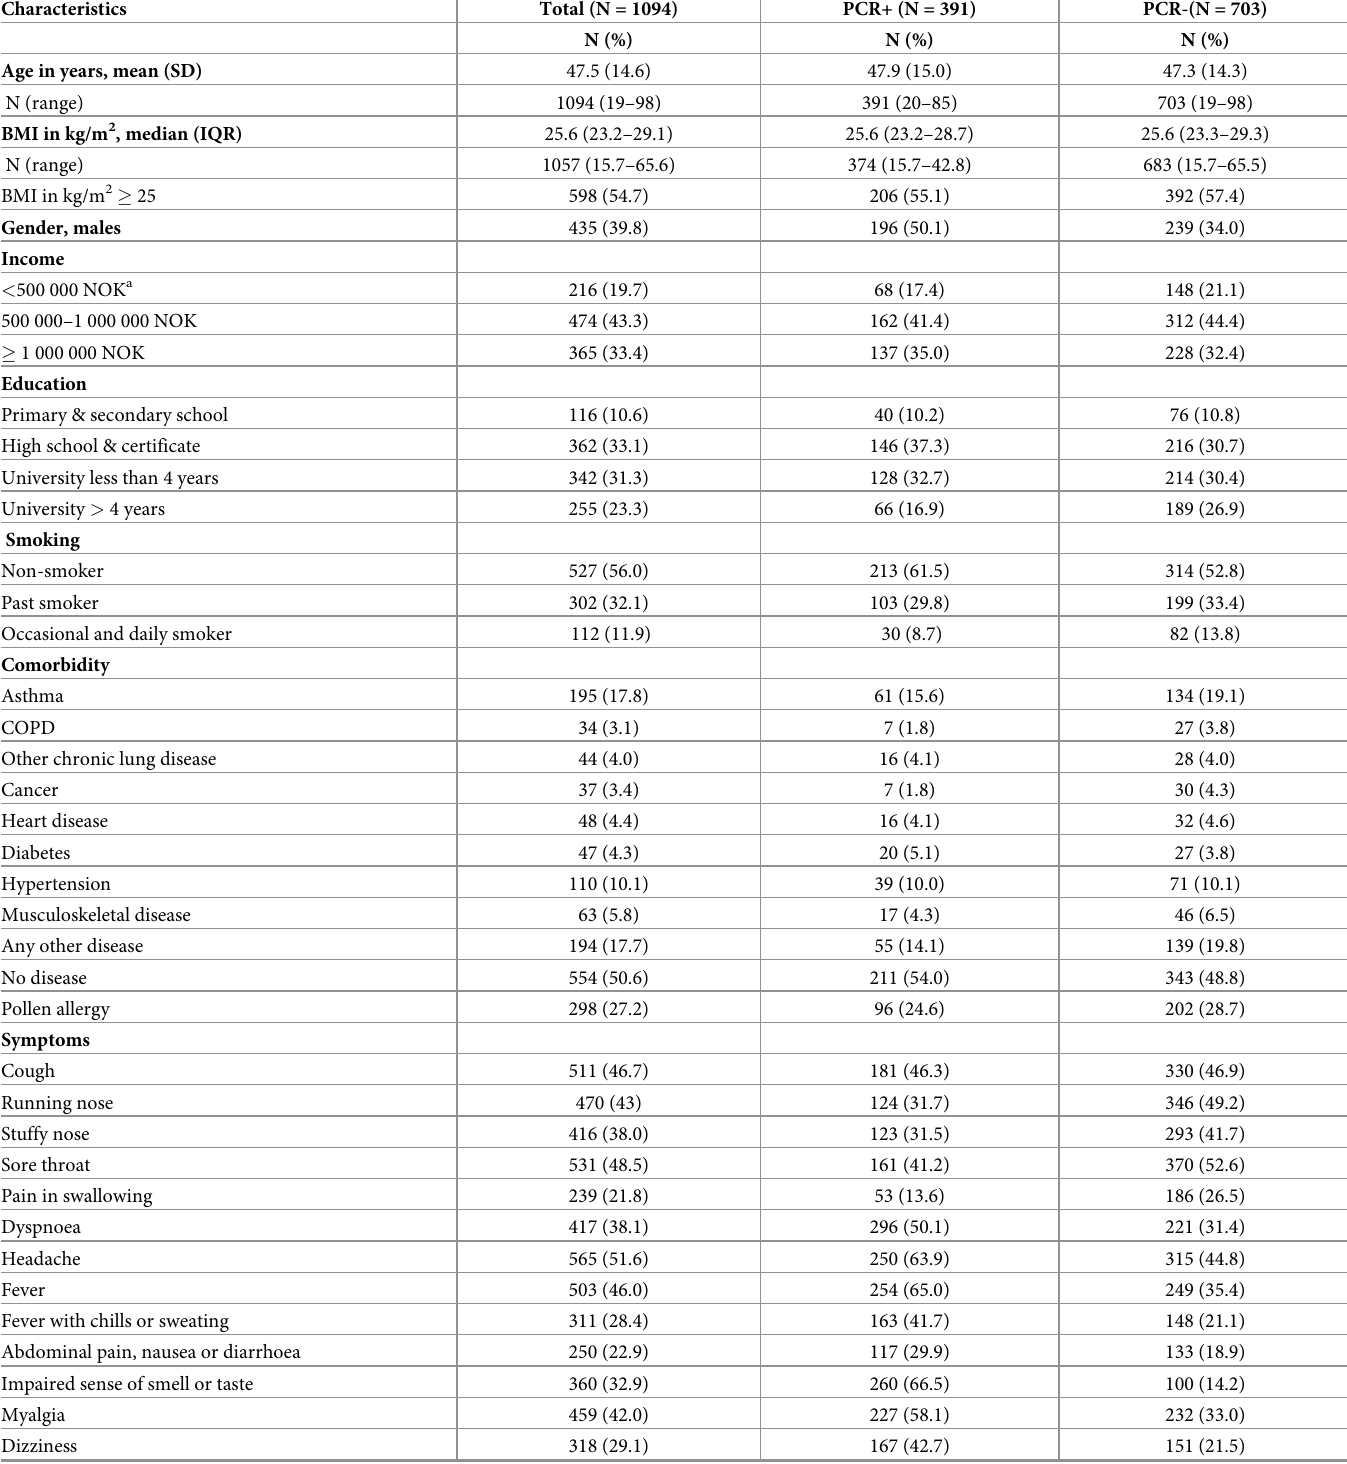
Table 1. Characteristics of the PCR positive (PCR+) and PCR negative (PCR-) participants at the first antibody test (T1).